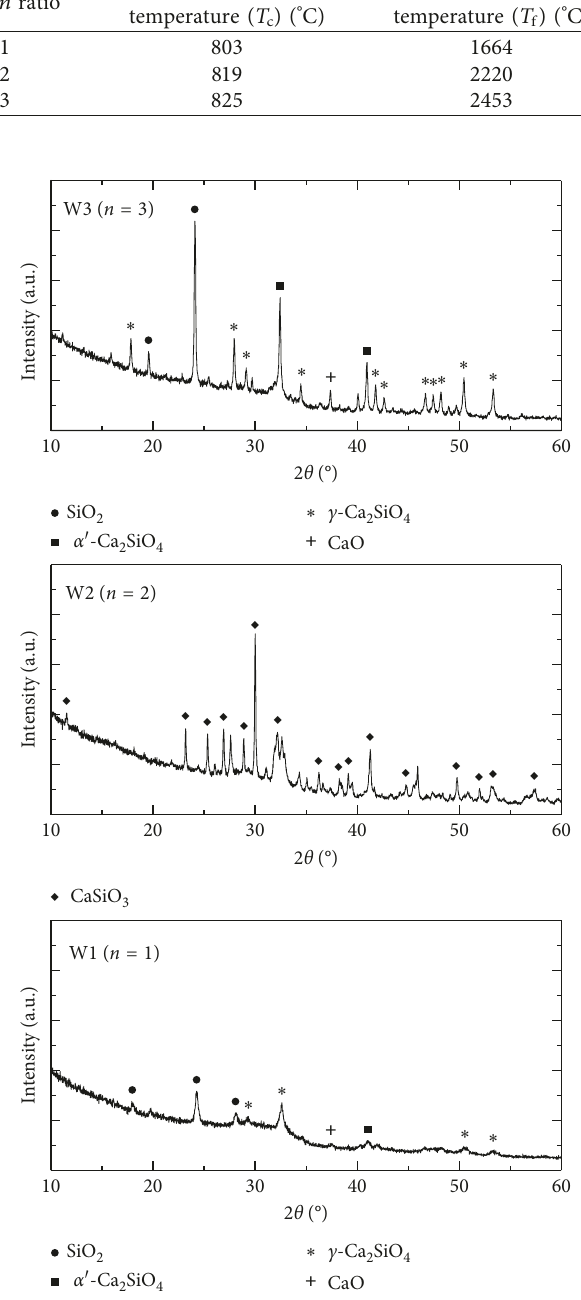
Figure 2: XRD patterns of combustion synthesis powders obtained from systems containing different amounts of